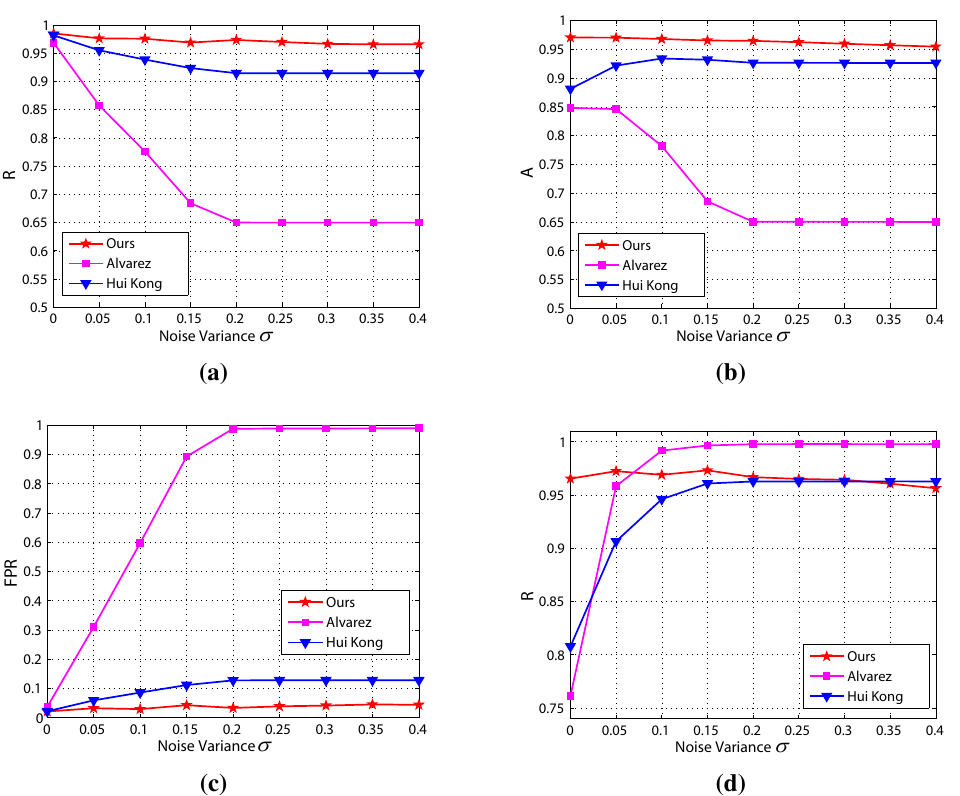
Figure 22. Results of the noise sensitivity evaluation: ( a ) precision; ( b ) accuracy; ( c ) false positive rate; ( d )